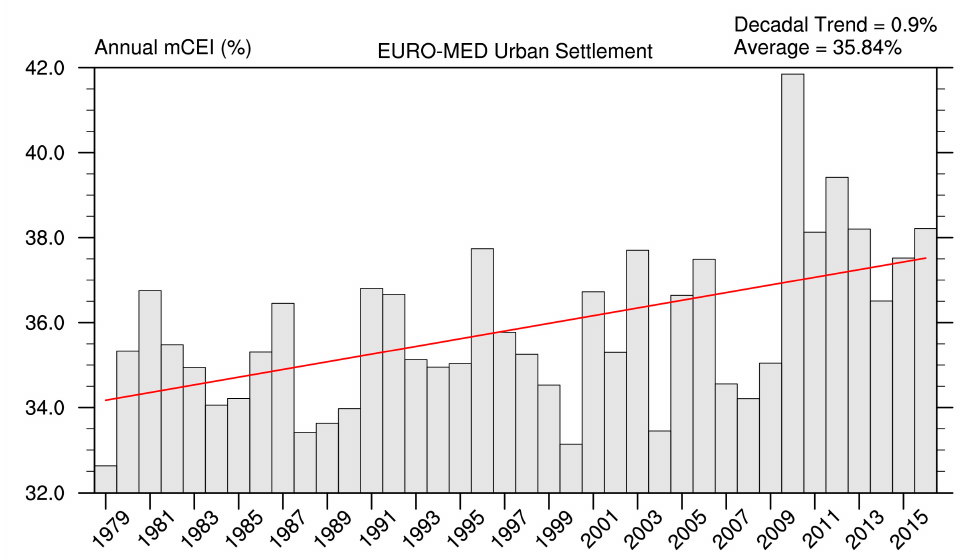
Figure 14. Spatial averages of mCEI over the urban settlements of the EURO–MED